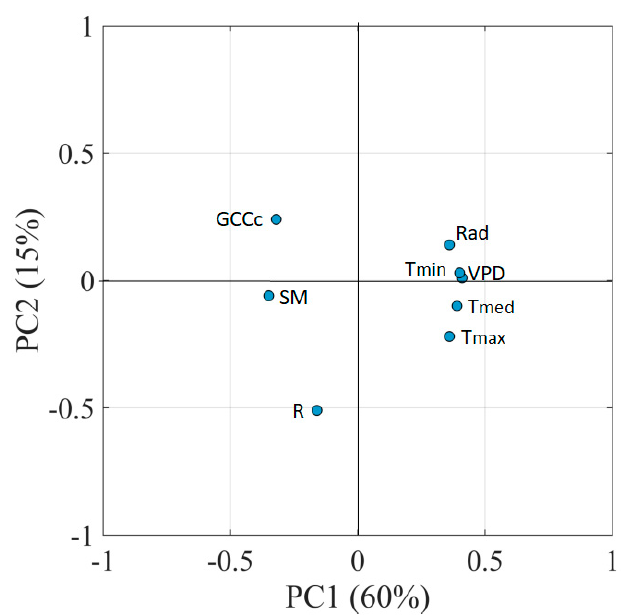
Figure 7. Principal component analysis (PCA) of GCCc and abiotic variables. The two first principal components (PCs) are shown. Between parenthesis: percentage of variance explained.